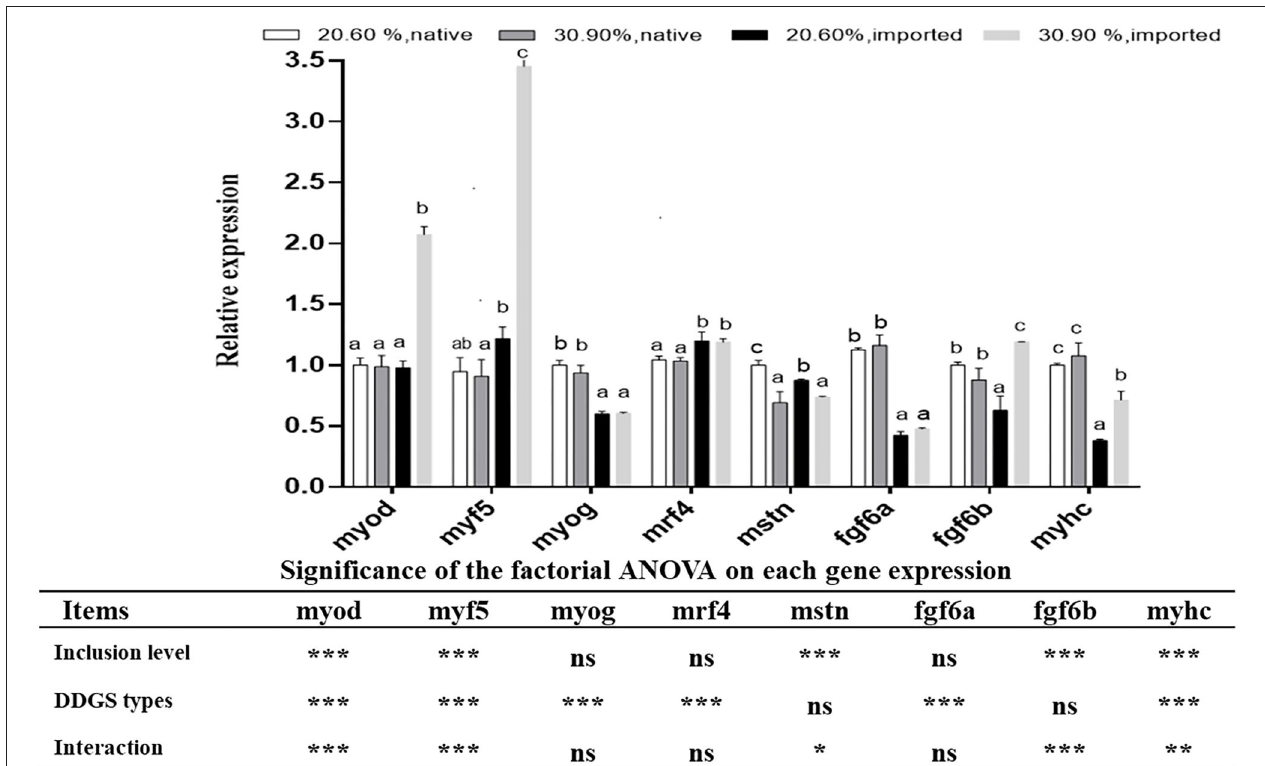
FIGURE 3 | Muscle growths related gene expressions in grass carp white muscle tissue received different DDGS levels and types. Data represented the means ± SD. Bars with different letters denote significant difference between groups ( p < 0.05). * p ≤ 0.05; ** p ≤ 0.01; *** p ≤ 0.001 and ns: no significance, which mean the effect of the DDGS type and level as well as their interaction on each gene expression by the factorial